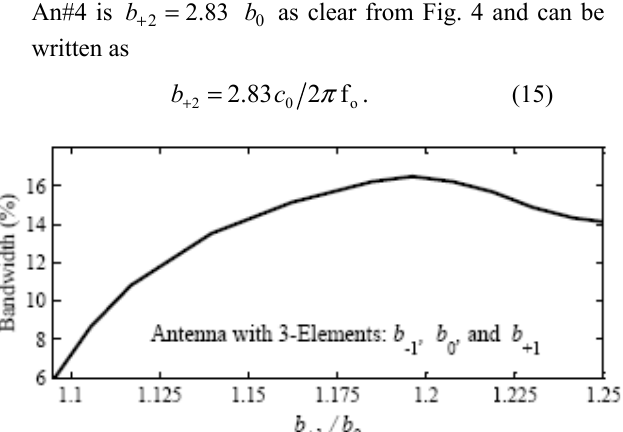
Figure 3: Variation of the bandwidth of a 3-element CCLA with b . +1